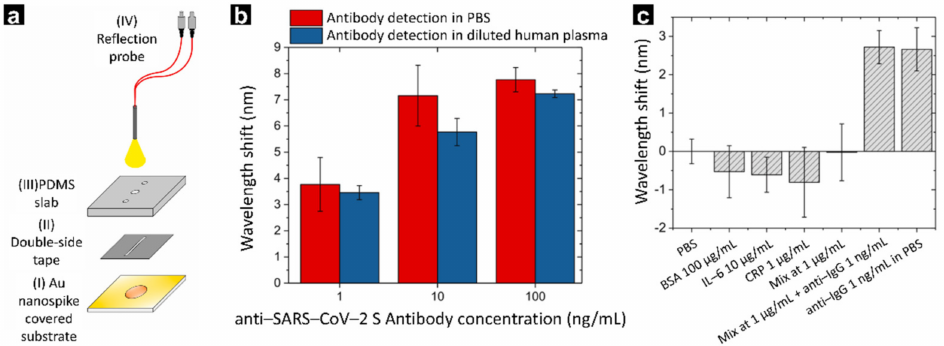
Figure 3. ( a ) Schematic illustration of the fabricated gold nanospike-based SPR sensor. ( b ) Plot representing the detection limit for the analyte. ( c ) Selective affinity test against other interference substances. With permission from [81], Copyright 2020,